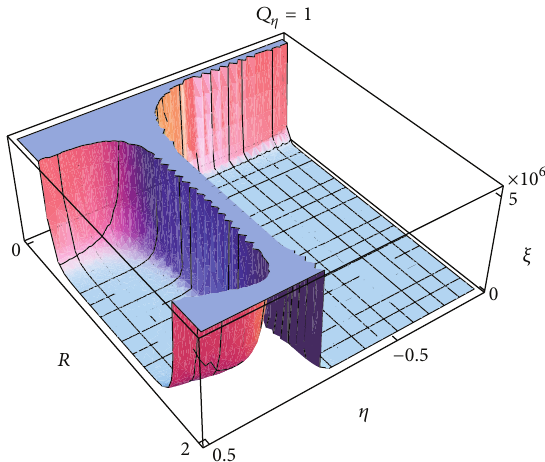
Figure 7: 4D Kretschmann invariant 𝜉 for 𝑄 𝜂 = 1 , for Λ = 0